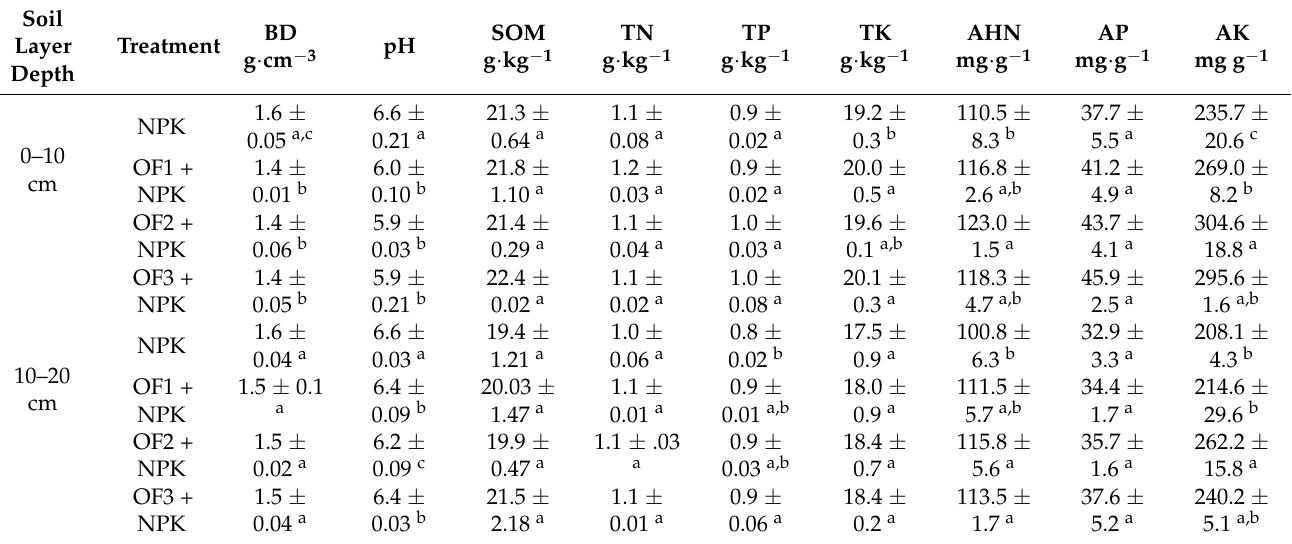
Table 1. Effects of organic–inorganic fertilizers on soil physical and chemical properties in a dry direct-seeded rice paddy soil.